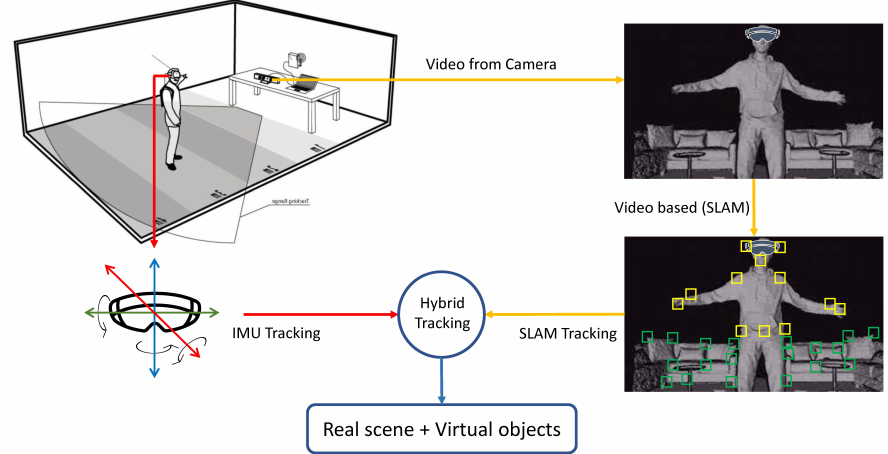
Figure 6. Hybrid tracking: inertial and SLAM combined and used in the latest mobile-based AR